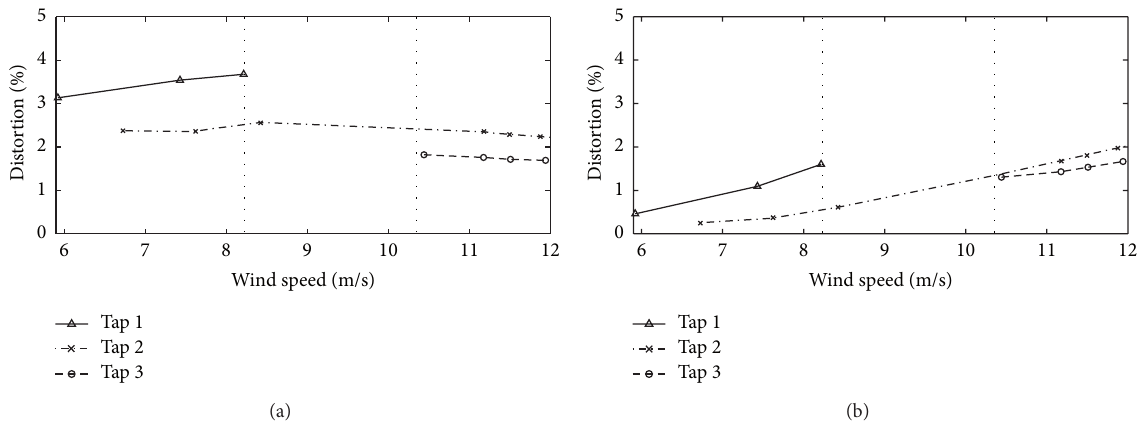
Figure 8: Results from the experiments for all three taps on the tap transformer (a) THD (b) TDD. The vertical lines in the two figures correspond to one-third and two-thirds of the nominal power from the turbine. We can see an improvement in THD as we go up in power and an improvement in both THD and TDD as we go up in tap.